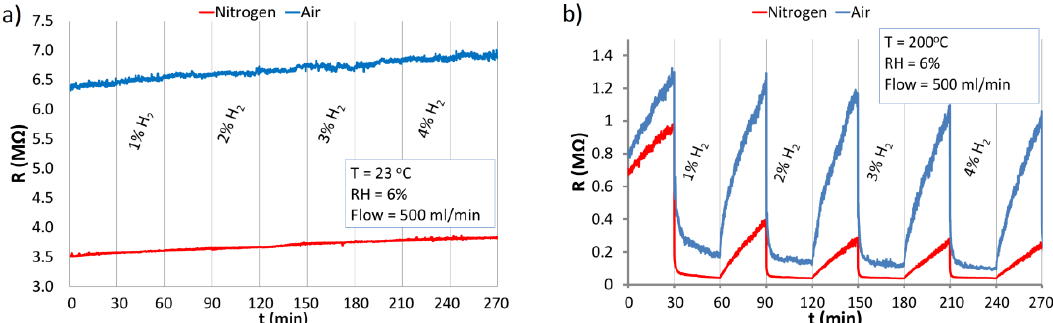
Figure 10. Reaction of the ZnO nanostructures with H 2 in the atmosphere of synthetic air and nitrogen at: ( a ) RT; ( b ) temperature of 200 °C.